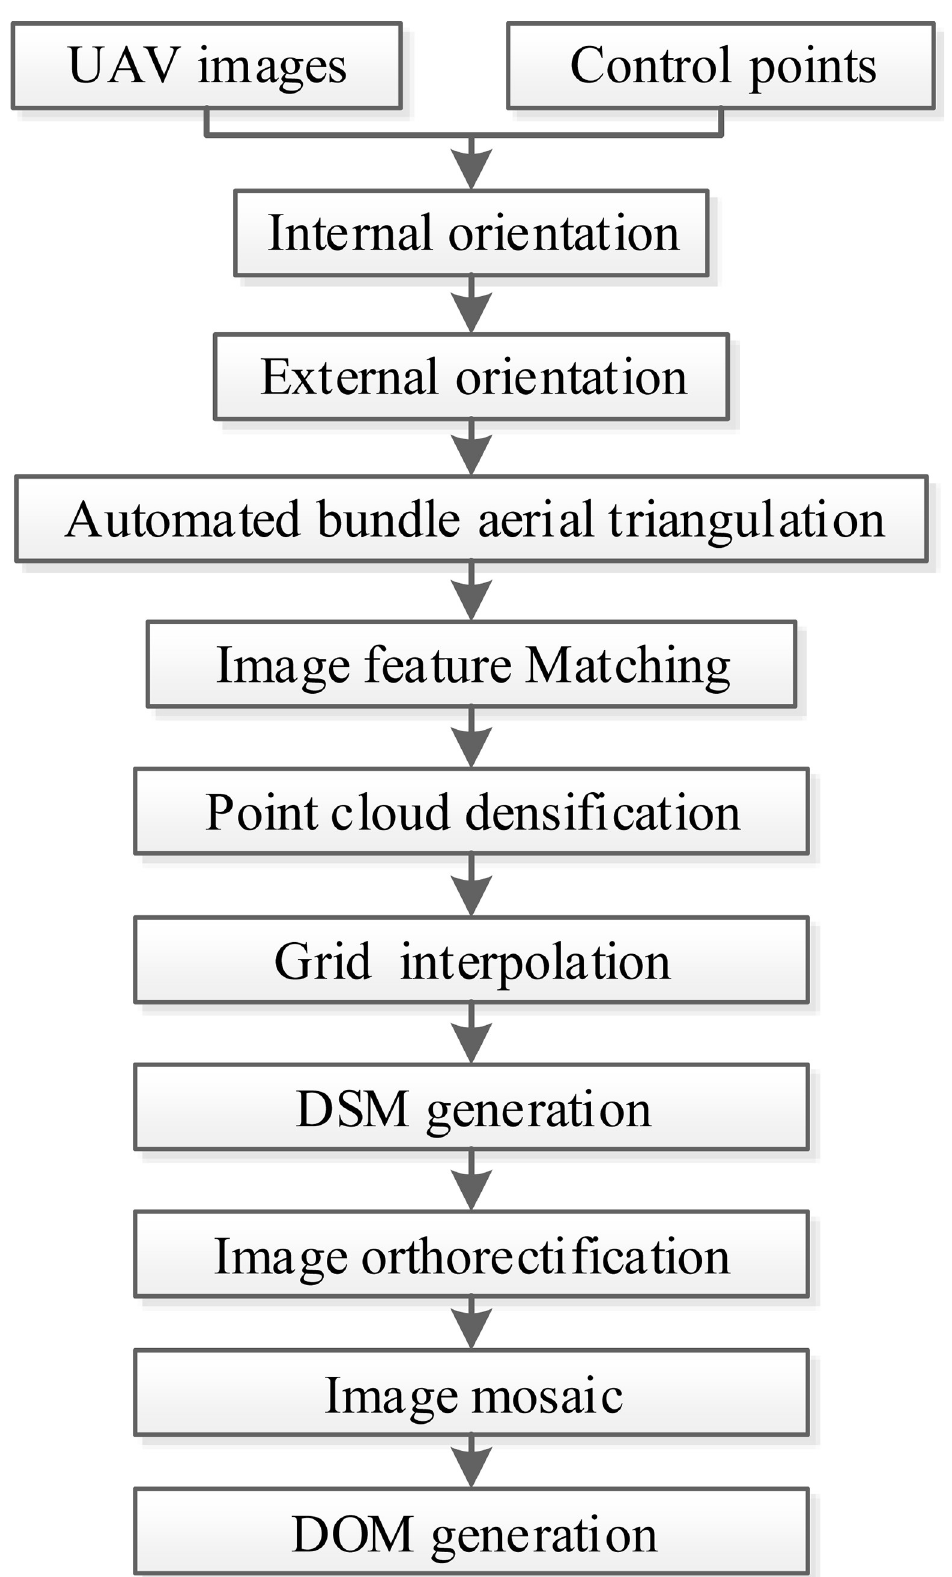
Fig 2. The workflow of photogrammetric processing based on Pix4dmapper software. https://doi.org/10.1371/journal.pone.0247682.g002 PLOS ONE | https://doi.org/10.1371/journal.pone.0247682 March 29,